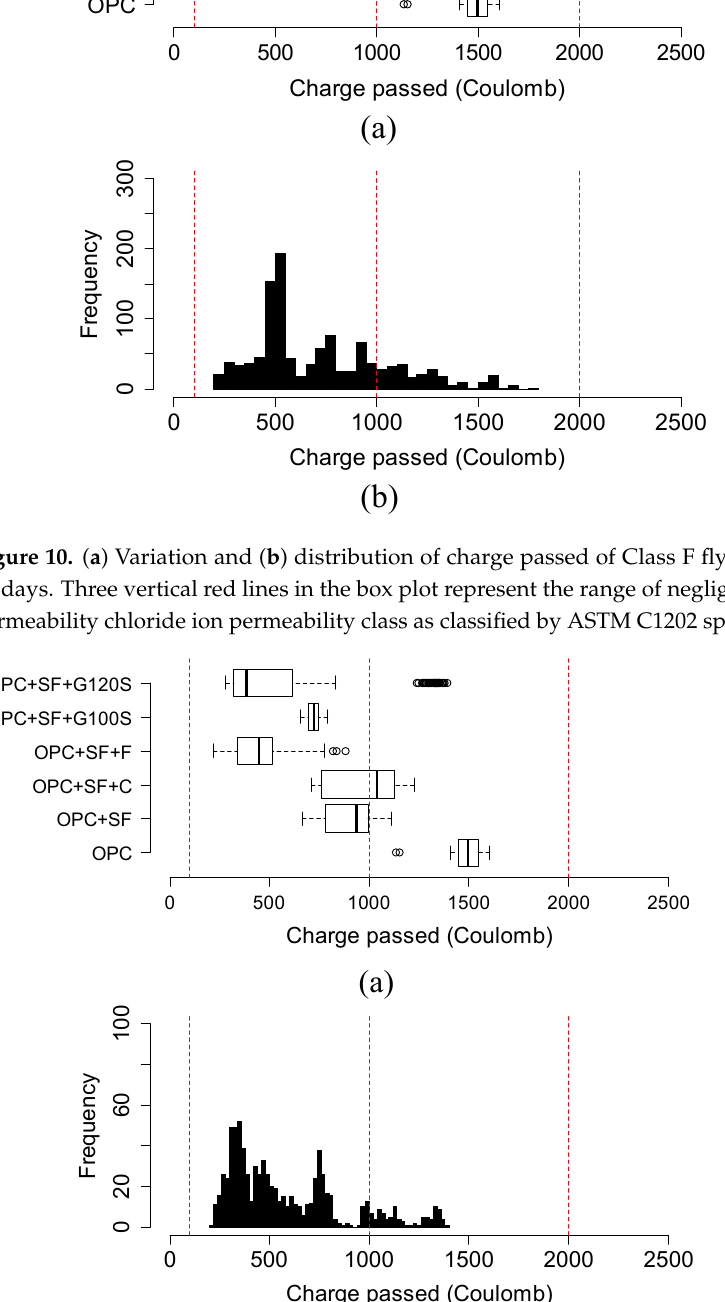
Figure 11. ( a ) Variation and ( b ) distribution of charge passed of silica fume-based mixtures at 91 days. Three vertical red lines in the box plot represent the range of negligible, very low, and low permeability chloride ion permeability class as classified by ASTM C1202 specification.